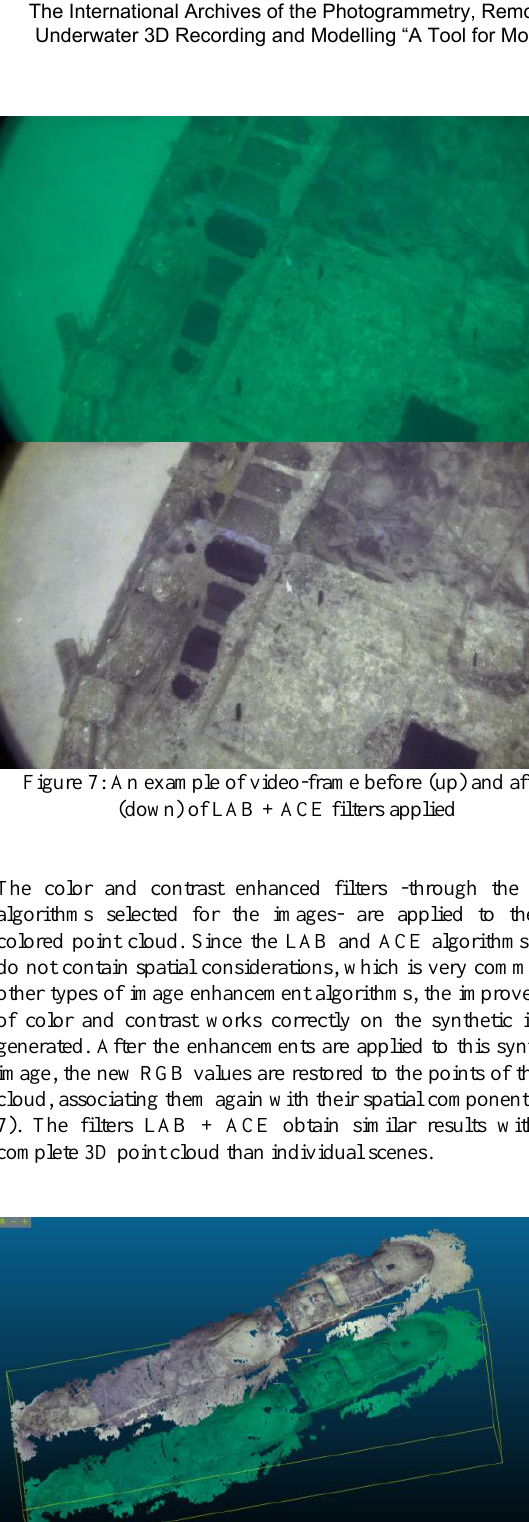
Figure 8: 3D point clouds before (down) and after (up) enhancement. A fictitious geometric displacement in z values has been introduced for the correct visualization of the two datasets.